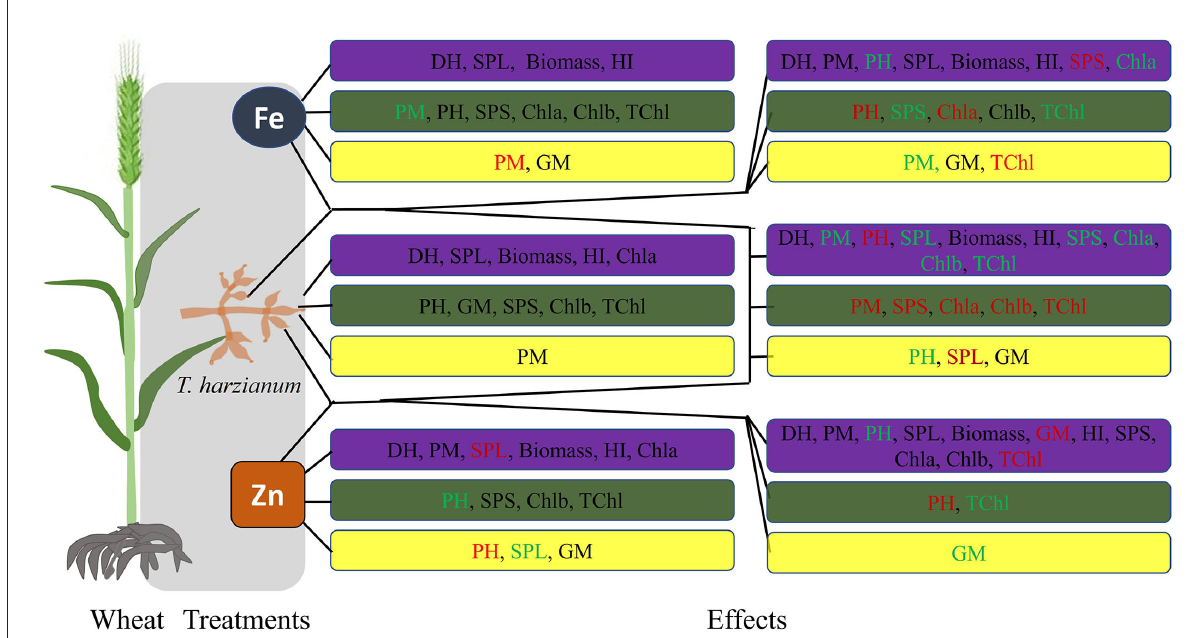
FIGURE2 Overview of wheat responses for the studied traits to different treatments. Blue boxes represent enhanced effect; green boxes represent no significant differences; while, yellow boxes represent negative/decreased effect of the respective treatment, in comparison to control. Further, the black font color of the studied trait represents a response to both low and high concentration; the red color represents a response to low concentration; while, the green color represents a response to the high concentration of the respective